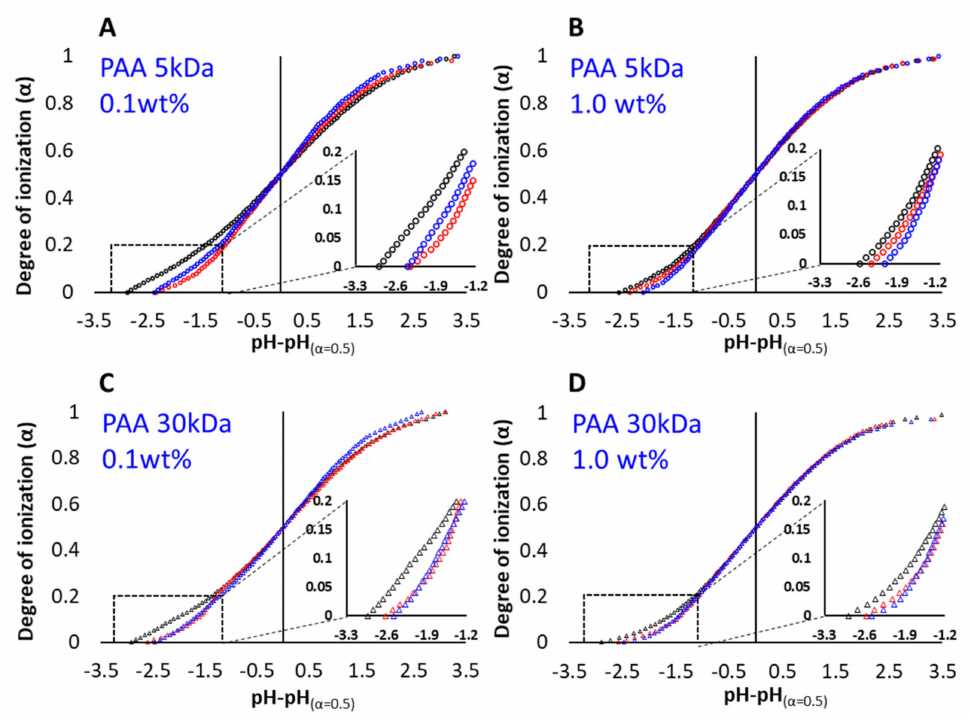
Figure 2. Titration curves of PAA presenting the degree of ionization ( α ) as a function of ∆ pH (pH-pH ( α = 0.5). ) in water ( black ) and in micellar solutions of Brij-S20 1 wt% ( red ) and F127 5 wt% ( blue ). ( A ) PAA 5kDa 0.1 wt%, ( B ) PAA 5kDa 1 wt%, ( C ) PAA 30kDa 0.1wt%, ( D ) PAA 30 kDa 1